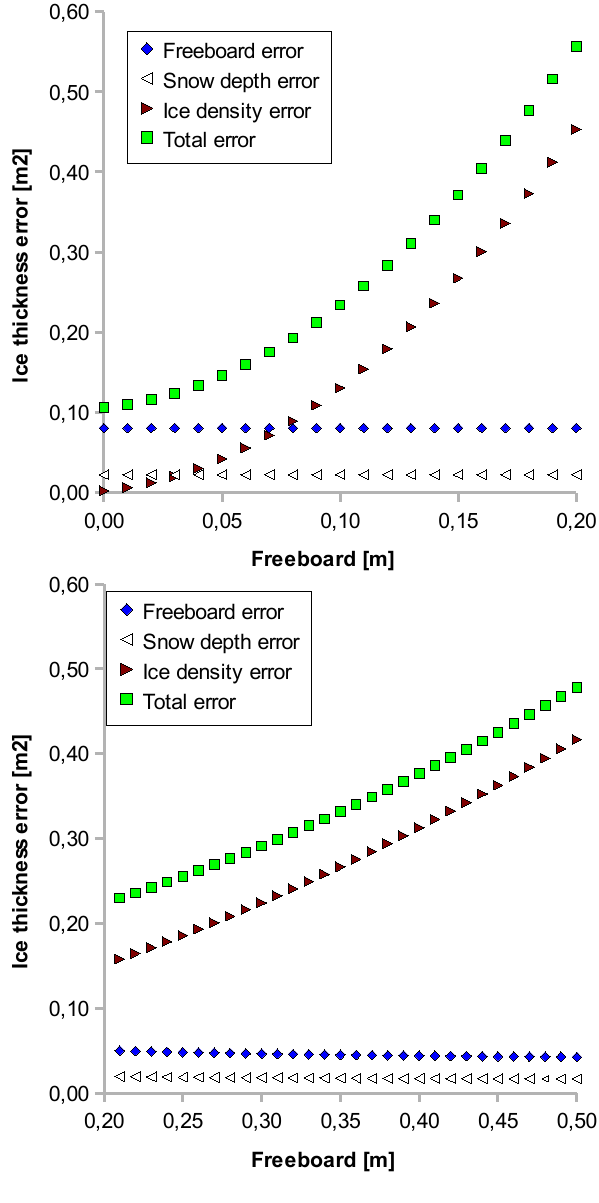
Fig. 3. Error terms contributing to uncertainty in ice thickness re- trieval from freeboard measurements for first-year (left) and multi- year (right) ice. The prescribed error of ice freeboard is